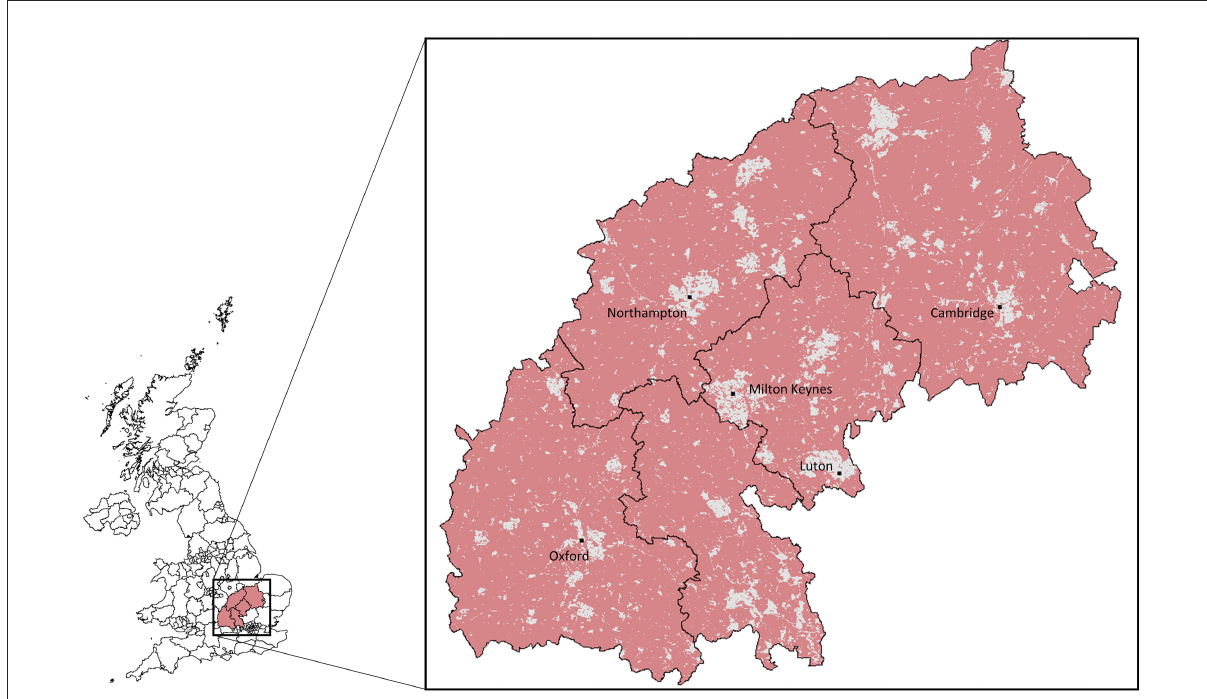
FIGURE2 An outline map of the case study location showing existing urban development (gray).